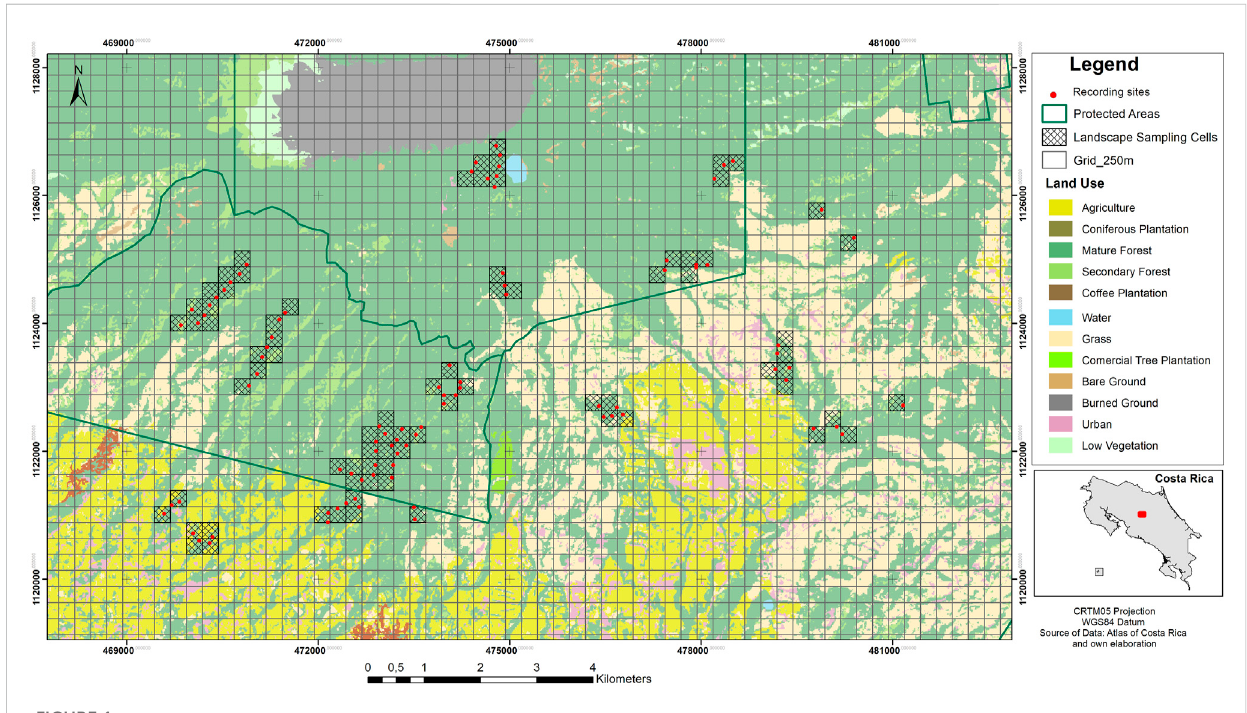
Study area in the Central Conservation Area of Costa Rica, 2019 –